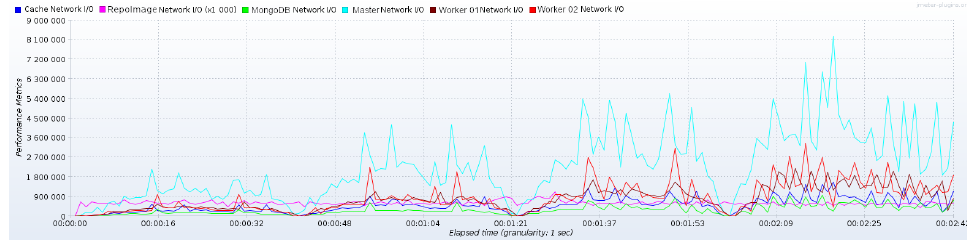
Figure 15. Communication cost in bytes reported by